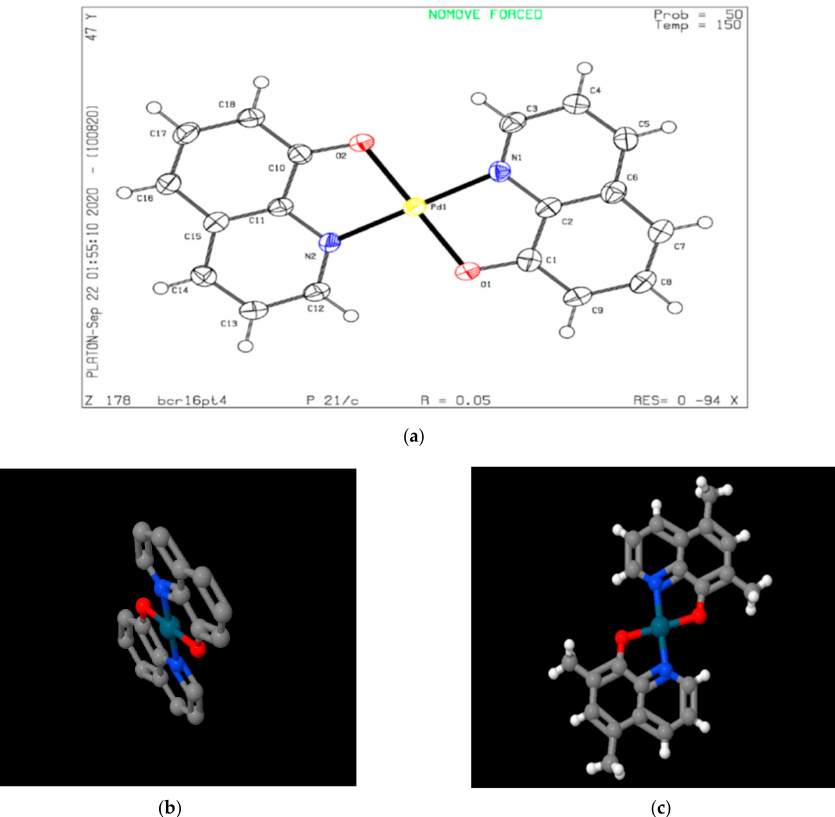
Figure 2. ( a ) ORTEP Structure of NH3 ( b ) ORTEP structure of HQUIPD ( c ) ORTEP structure of HQUIPD01.